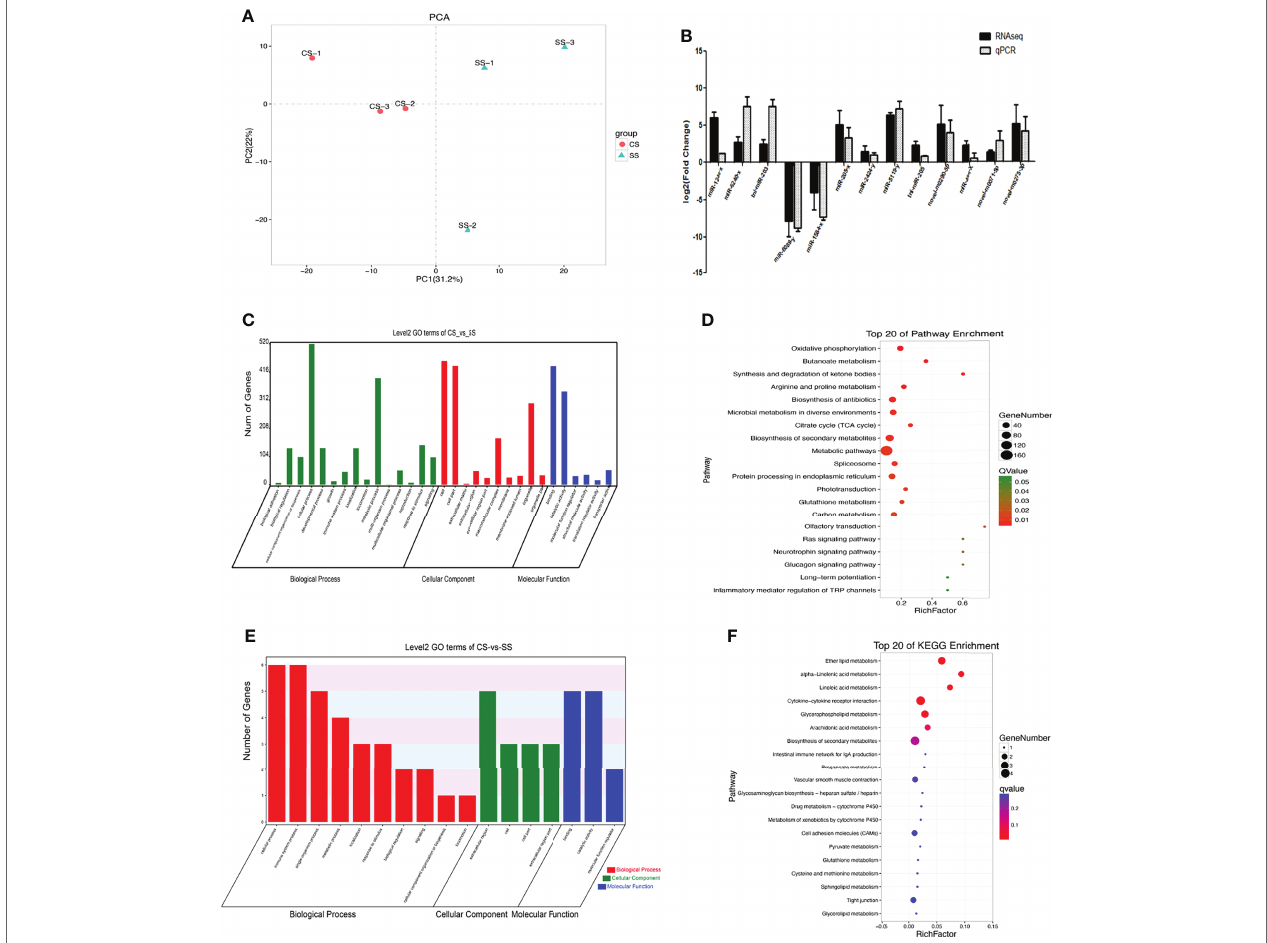
FIGURE 3 | miRNA analysis of DEMs. (A) PCA compared the differences in miRNA among the CS and SS groups. (B) Go analysis of DEMs. (C) Verification of representative DEMs by qRT-PCR. (D) KEGG enrichment analysis of DEMs. (E) Histogram of miRNAs’ negative correlation with target genes by GO enrichment. (F) A bubble diagram of miRNAs’ negative correlation with target genes by KEGG